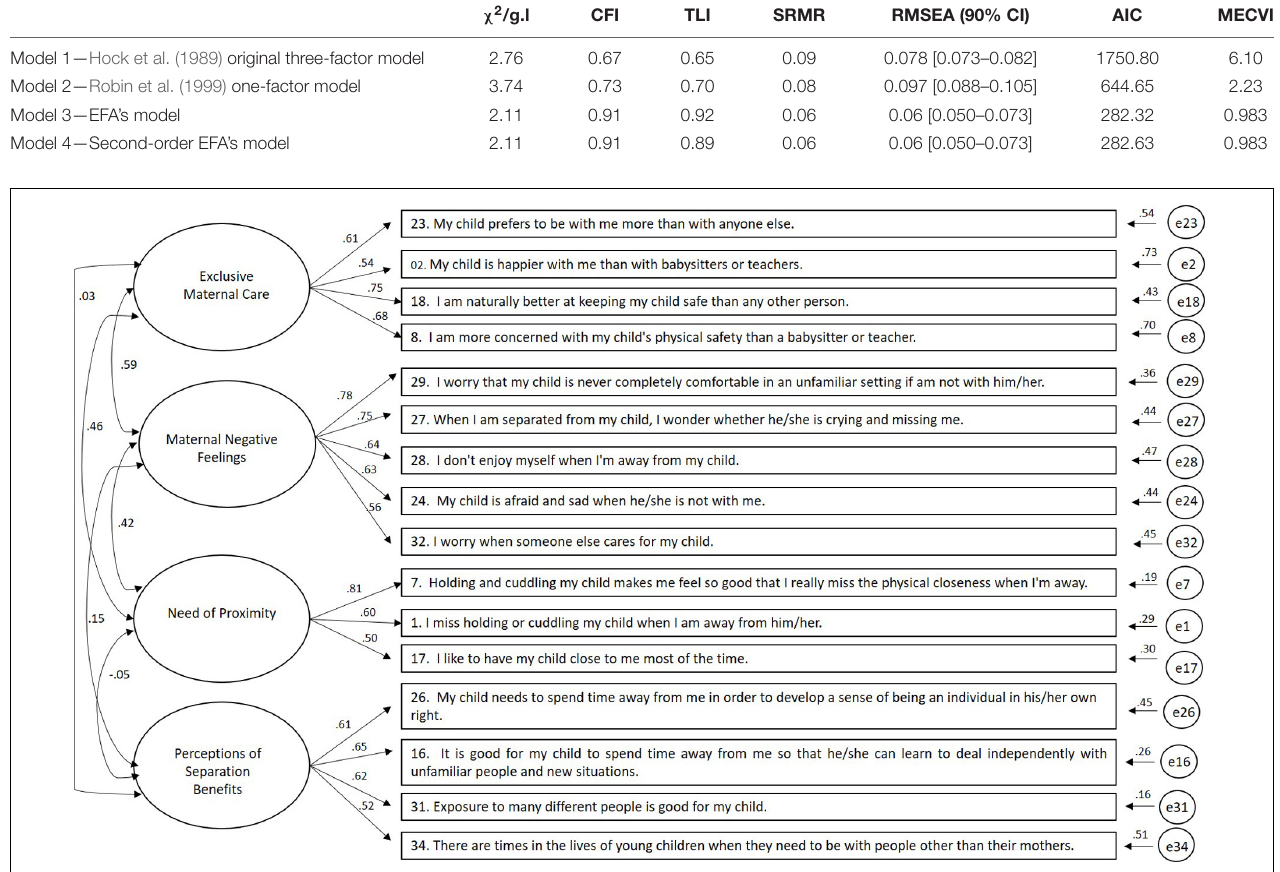
FIGURE 1 | Standardized parameters of the four-factor model of the Maternal Separation Anxiety Scale